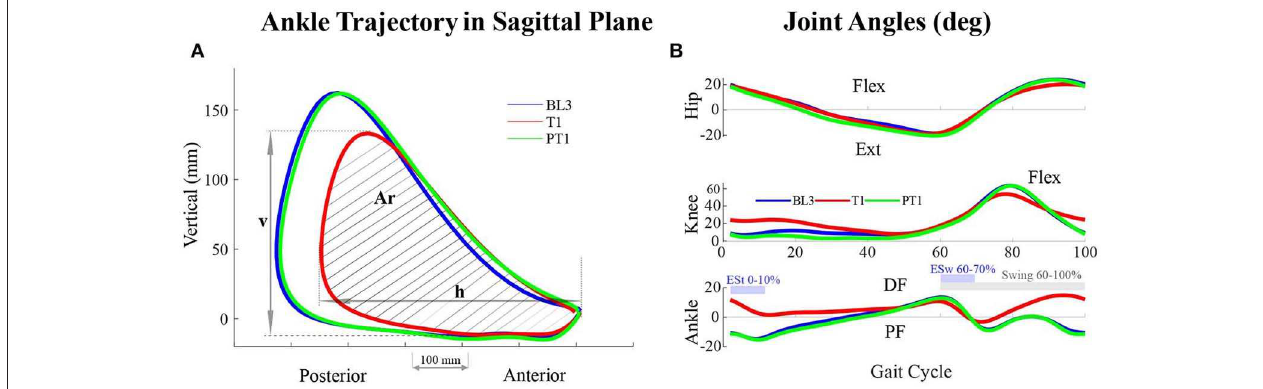
FIGURE 8 | (A) Ankle trajectory of the perturbed leg (right leg) in the sagittal plane of walking of a participant across sessions in Experiment II. The area enclosed within the trajectory (Ar) as well as the horizontal (h) and vertical (v) span decreased during the training (T1) session. (B) Joint angles of the perturbed leg of a participant across sessions in Experiment II. During the training (T1) session, the joint angles values vary with respect to baseline (BL3) and post-training (PT1) sessions. For the hip and knee joints, Flexion, Flex, is positive, and Extension, Ext, is negative. For the ankle joint, Dorsiflexion, DF, is positive, and Plantarflexion, PF, is negative.